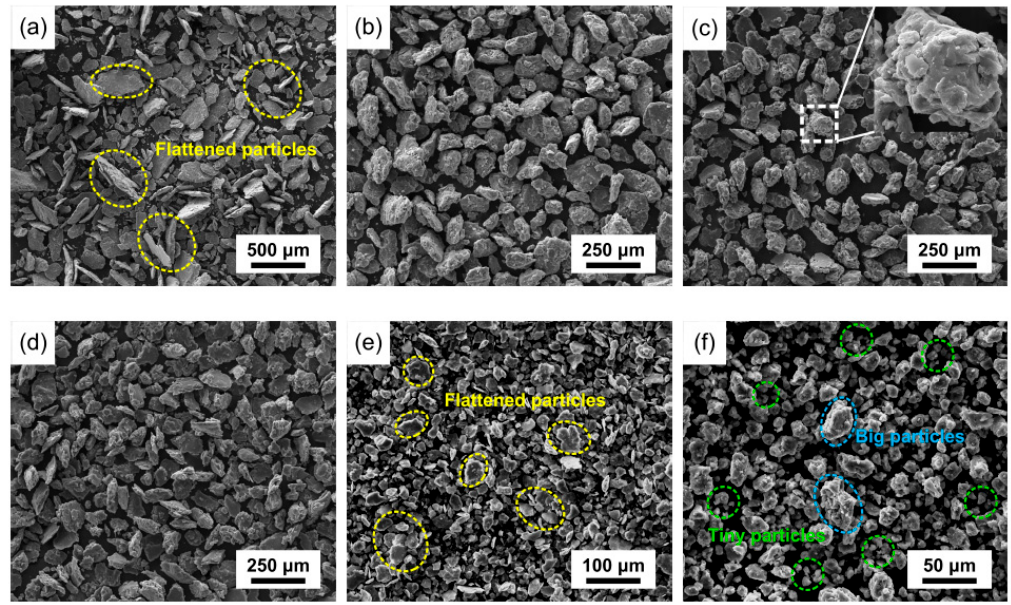
Figure 3. Morphology evolution of SiCp/AZ91 composite: ( a ) 15 min; ( b ) 30 min; ( c ) 60 min; ( d ) 120 min; ( e ) 180 min; ( f ) 240 min.